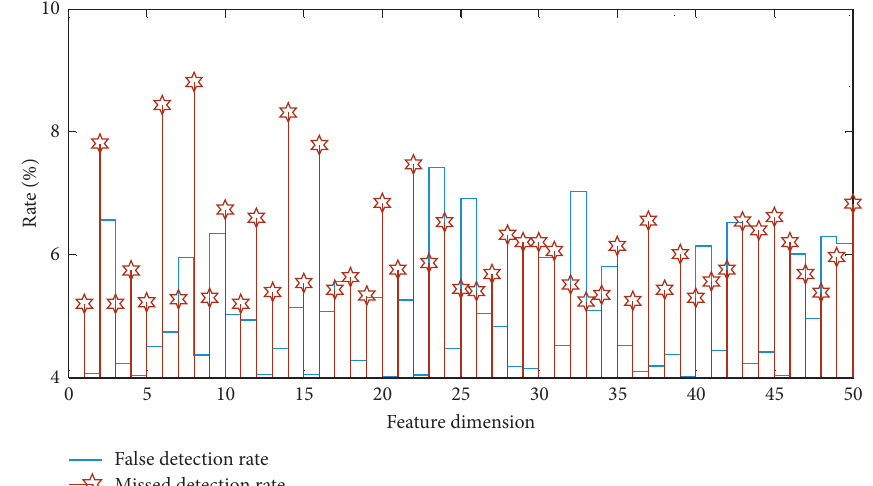
Figure 8: The missed detection rate and false detection rate of the image under the change of dimensionality.